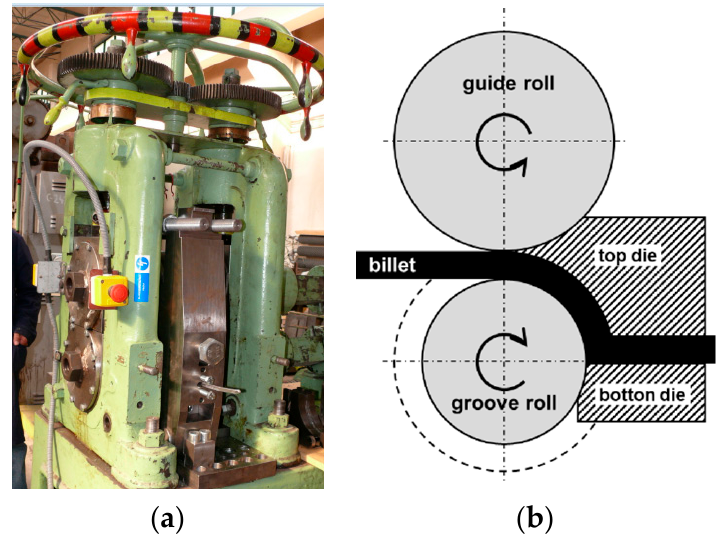
Figure 1. ( a ) The ECAR equipment; ( b ) The schema of the ECAR process.